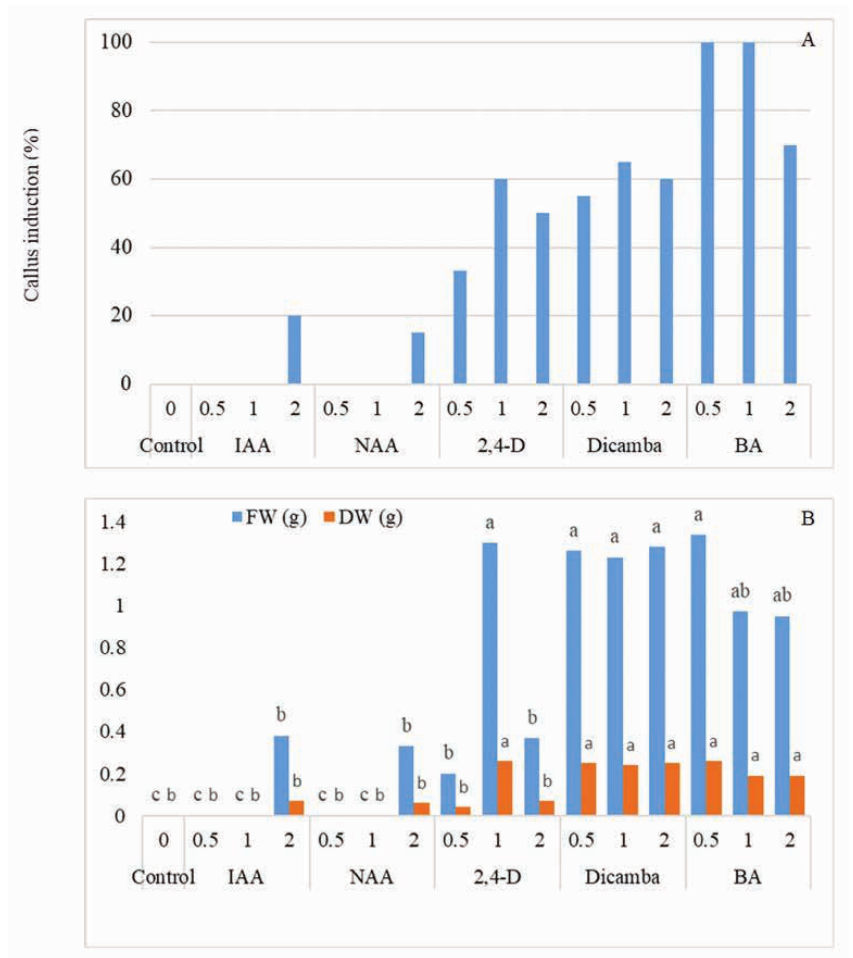
Figure 2: Effect of plant growth regulators on the percentage of callus induction (A) and fresh and dry weight of the ginger’s callus (B). Means with shared letter(s) in each column for each factor showing insignificant differences (LSD, α≤